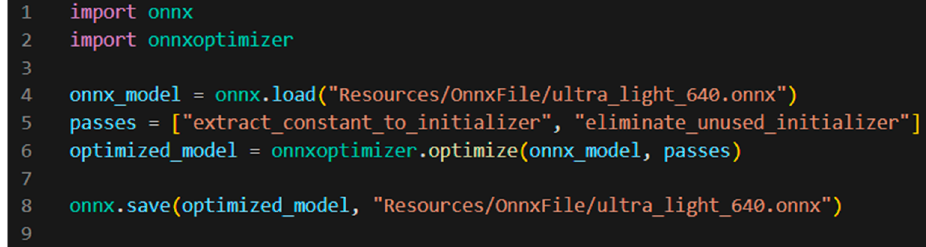
Figure 8. Code of the model loader.